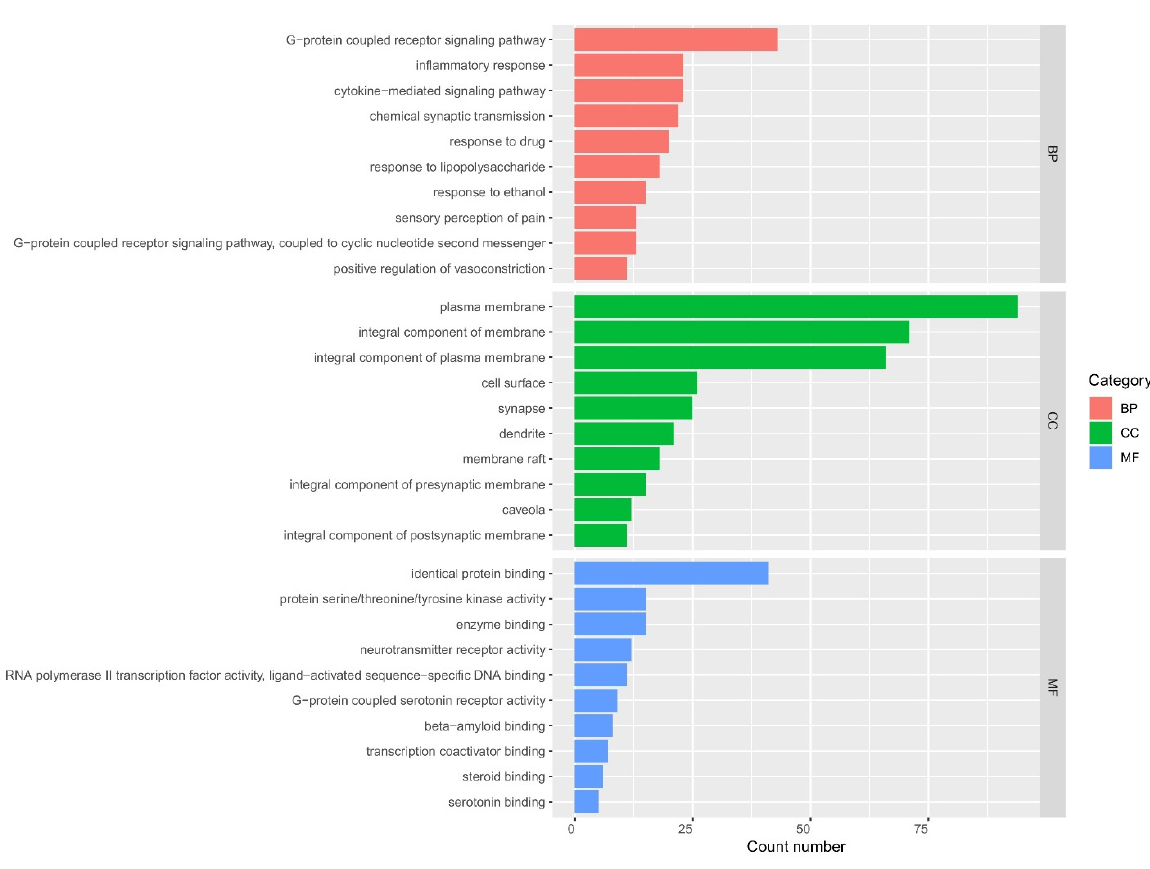
Figure 3. Identification of potential therapeutic targets for ALHP against migraines. ( A ) Construc- tion of PPI networks of overlapping genes between ALHP and migraines via STRING. ( B ) Signifi- cant module determined via the function of topology analysis in Cytoscape. ( C ) Four clusters were predicted and visualized via the cluster analysis with MCODE algorithm (K-core threshold = 2). BC, betweenness centrality; CC, closeness centrality; DC, degree centrality.